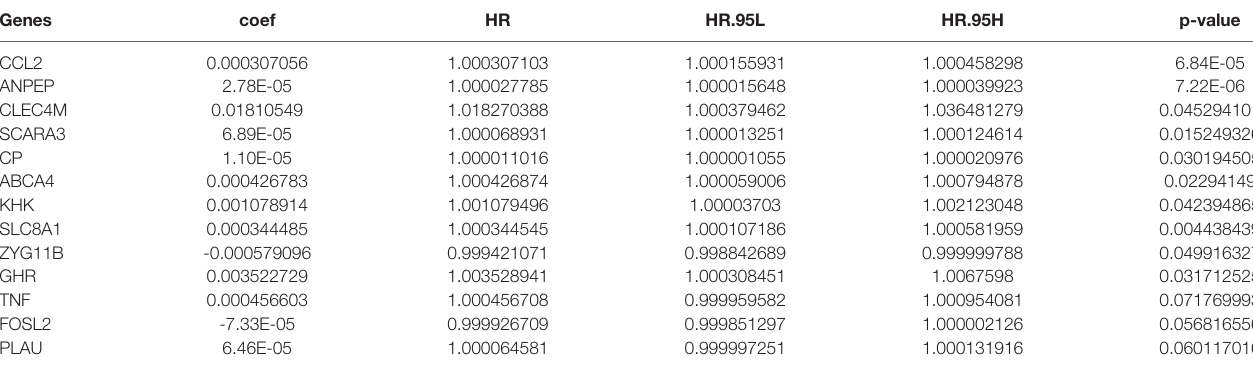
TABLE 2 | Multivariate ox proportional hazards regression